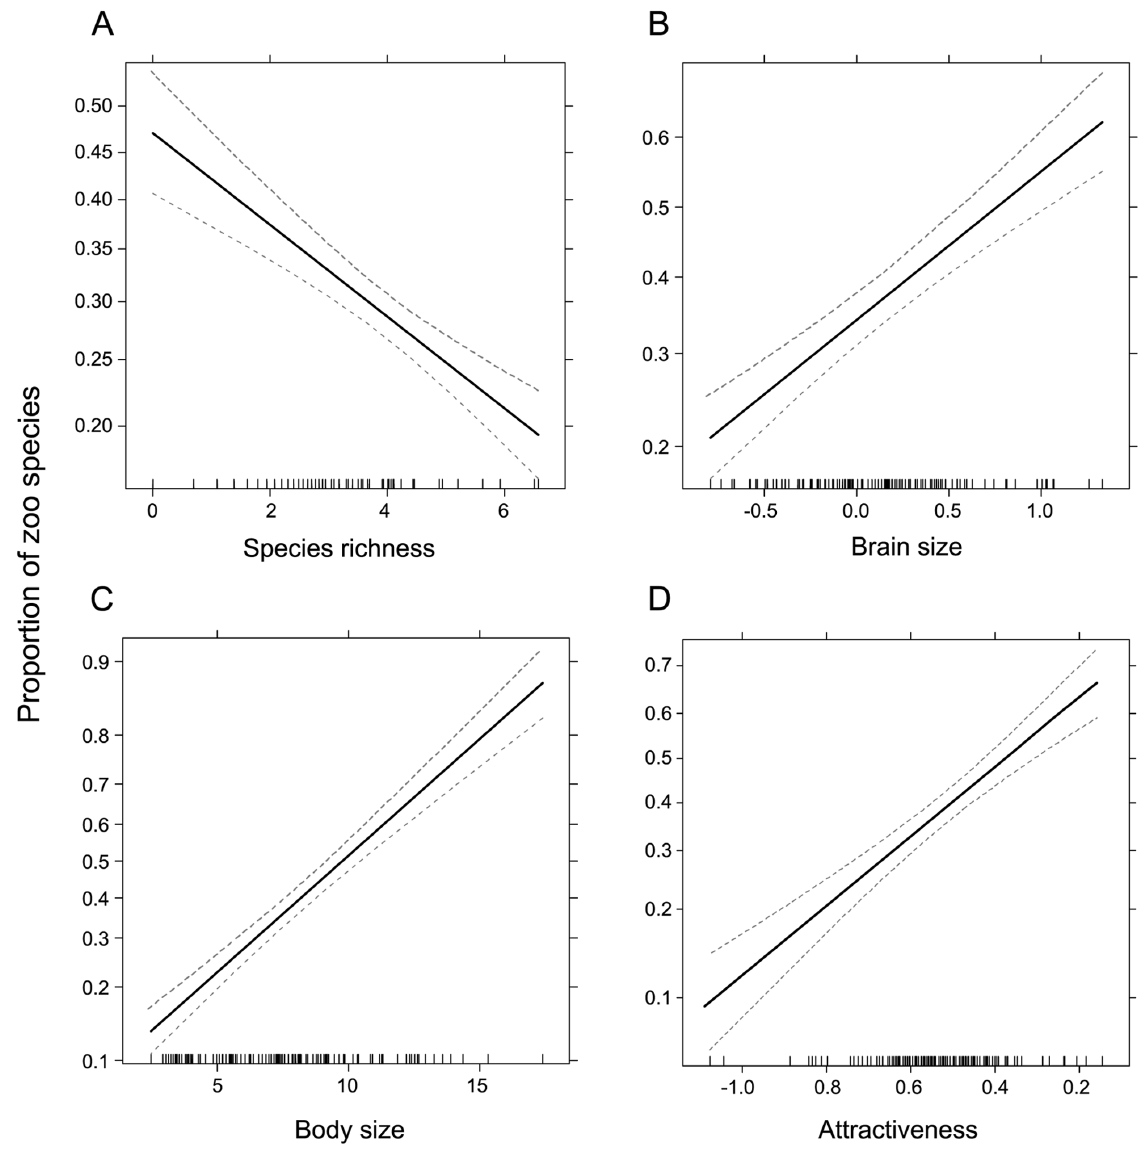
Figure 3. The proportion of zoo species as predicted by GLM. The effects of species richness (a), brain size (b), body size (c), and attractiveness (d). The dependent variable is the number of species kept in WZC scaled to the total number of extant species of a given family. This binomial variable reflects the mean probability that a species is kept in at least one zoo. For the definition and transformation of the explanatory variables see under the Material and methods section. and Laurasiatheria [17]. The results of this study first show this relationship across all mammalian families; the species belonging to aesthetically attractive families have a higher probability to be included in the WZC, and they tend to be represented by more numerous populations as well as being kept by more zoos.